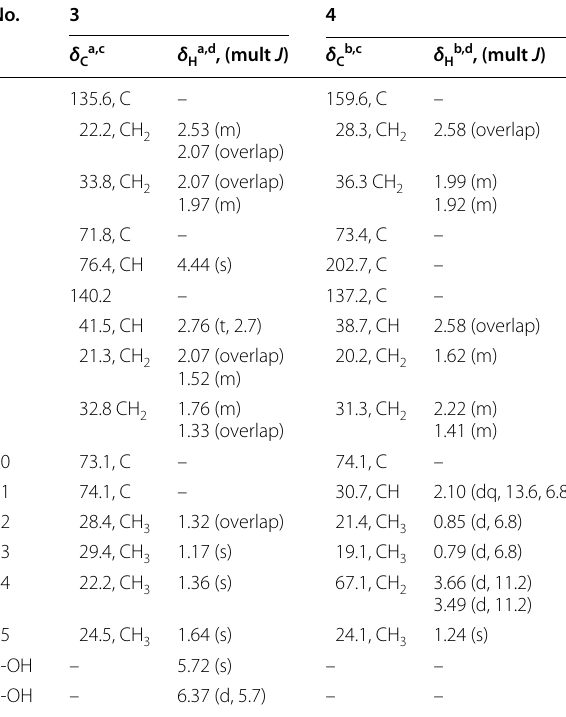
) -1 (black); calculated ECD − 1 nm, red) =